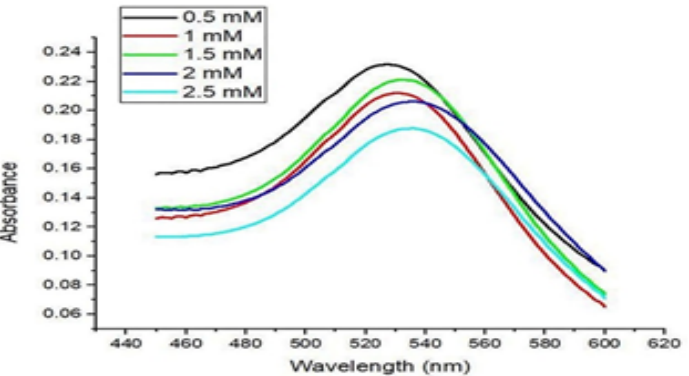
Figure 1. UV–Vis spectra of CIP, AuNPs, and CIP-AuNPs.